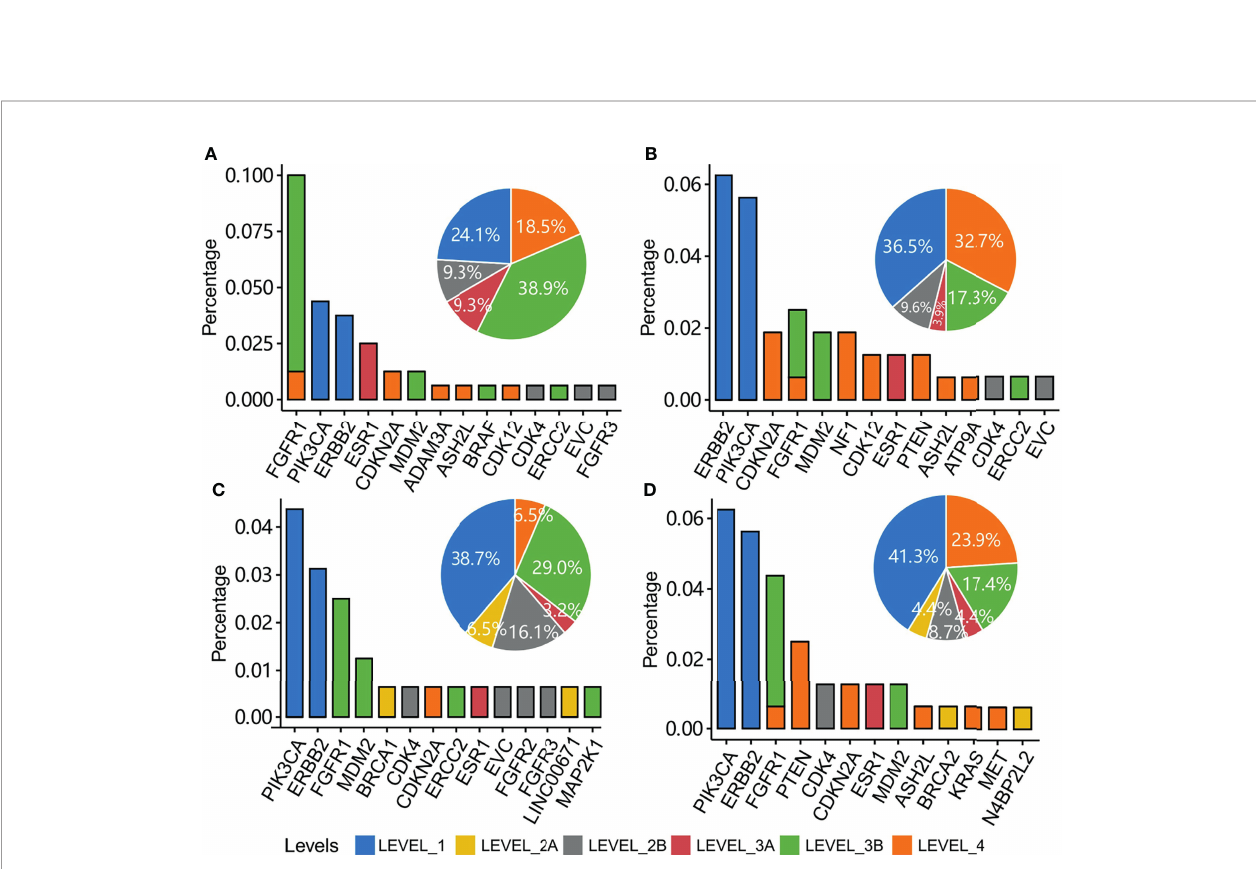
FIGURE 6 | Clinical actionability of somatic alterations for patients with mutations in each patient group. Percentage of patients with actionable genes are shown in patient groups 1 (A) , 2 (B) , 3 (C) , and 4 (D) . Bin sizes in the pie plot indicate the related percentage of actionable levels in each patient